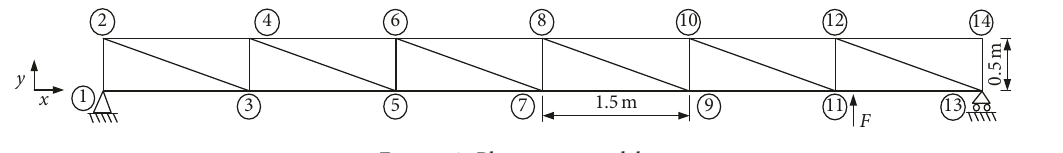
Figure 3: Plane truss model.